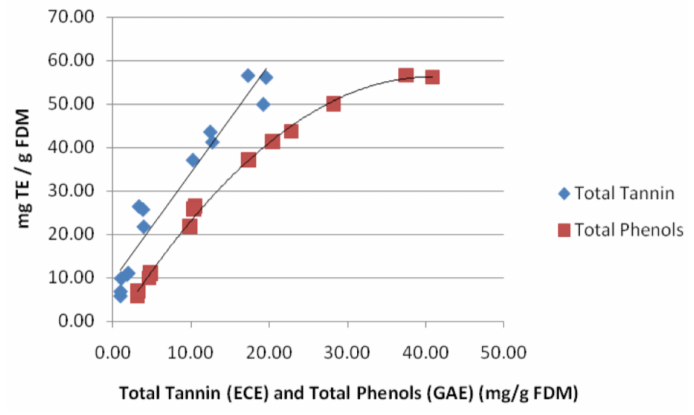
Figure 5. The relationship between the oxygen radical antioxidant capacity of total tannin content (TTC) and total phenol content (TPC) of wine lees. Table 4. Pearson’s coefficient correlations between TPC, TTC, mDP, and antioxidant activity (DPPH and ORAC) of extracts obtained from different wine lees using 50% extraction solvent of